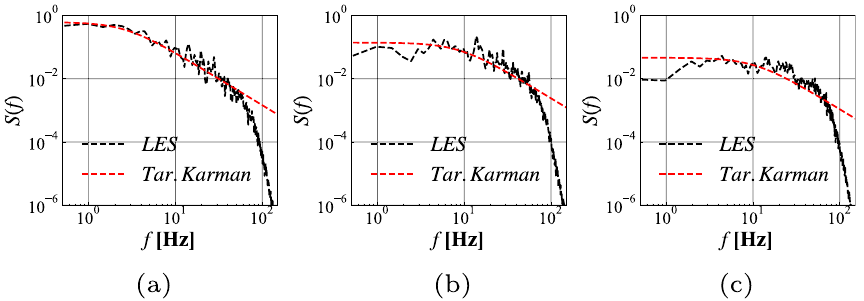
Fig. 4 The power spectral density of three velocity components at the building location: ( a ) u , ( b ) v and ( c )